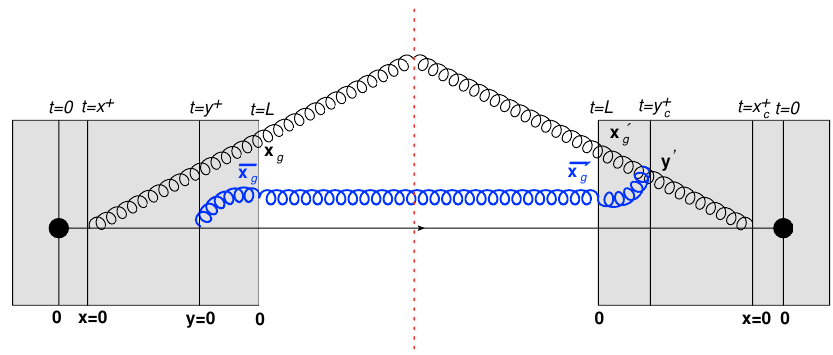
Figure 3 . Leading color interference diagram for the case of double in-medium gluon emission. We identify the different time scales (above) and the transverse position of each splitting